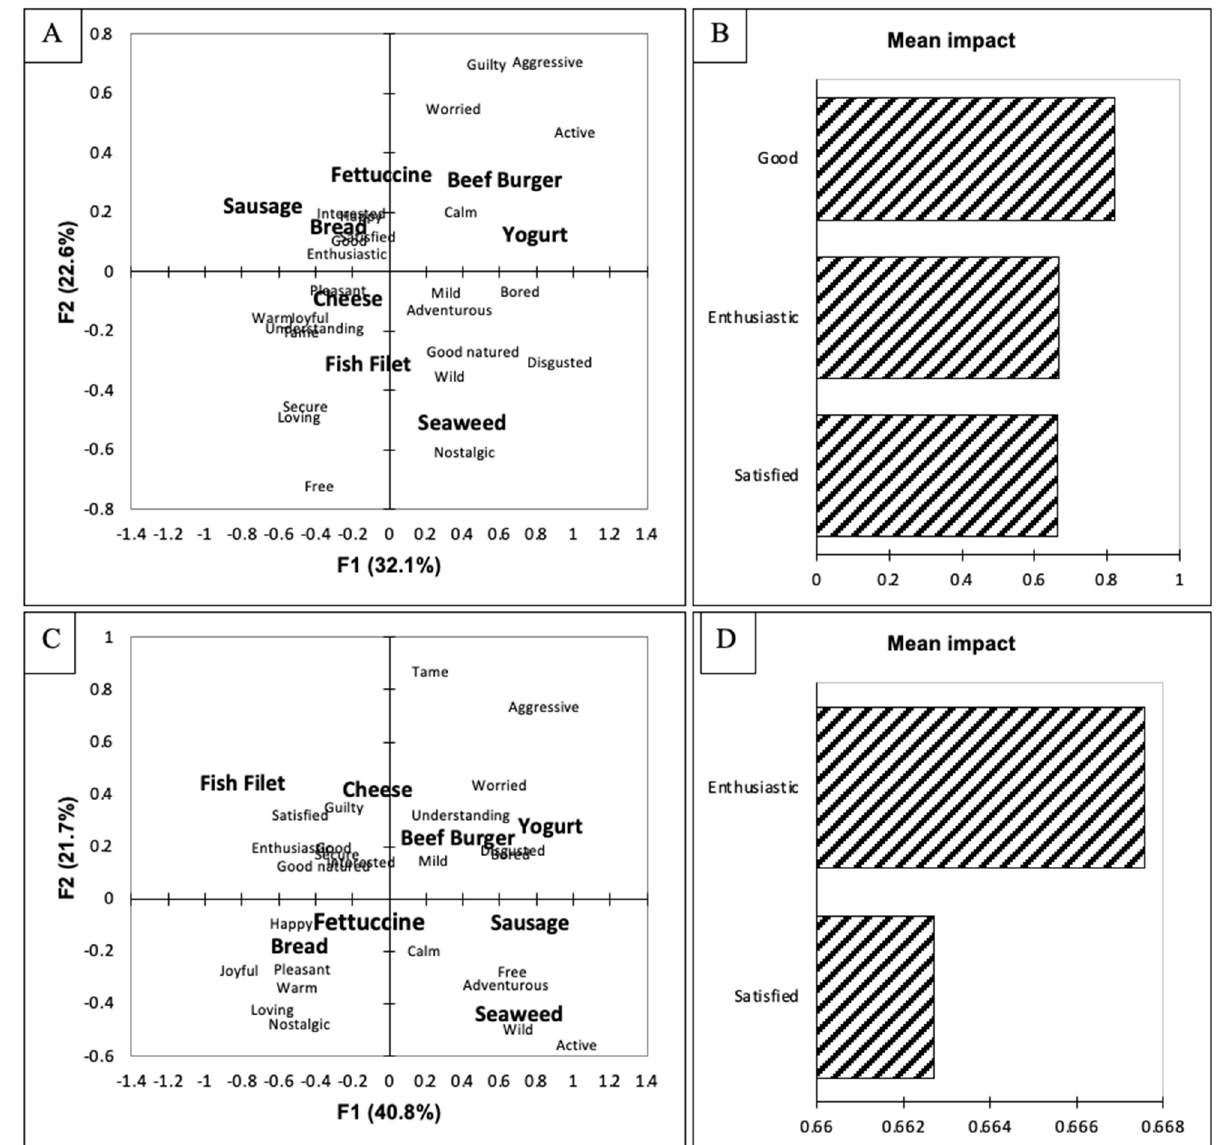
Figure 3. ( A ) Biplot representation of the seaweed-containing food items and emotional terms on the first two dimensions of the correspondence analysis for the population categorized as lower food neophobia (LFN). ( B ) Penalty lift analysis of the emotional terms and willingness to pay based on the LFN population’s evaluation of the seaweed-containing food items. ( C ) Biplot representation of the seaweed-containing food items and emotional terms on the first two dimensions of the correspondence analysis for the population categorized as higher food neophobia (HFN). ( D ) Penalty lift analysis of the emotional terms and willingness to pay based on the HFN population’s evaluation of the seaweed-containing food items.